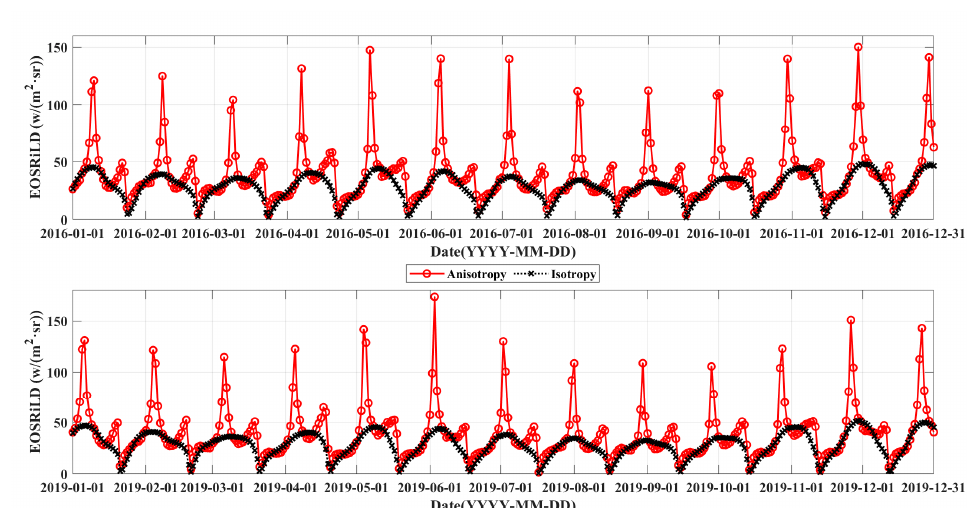
Figure 10. The simulation of daily EOSRiLD over Earth’s revolution period in 2016 and 2019.